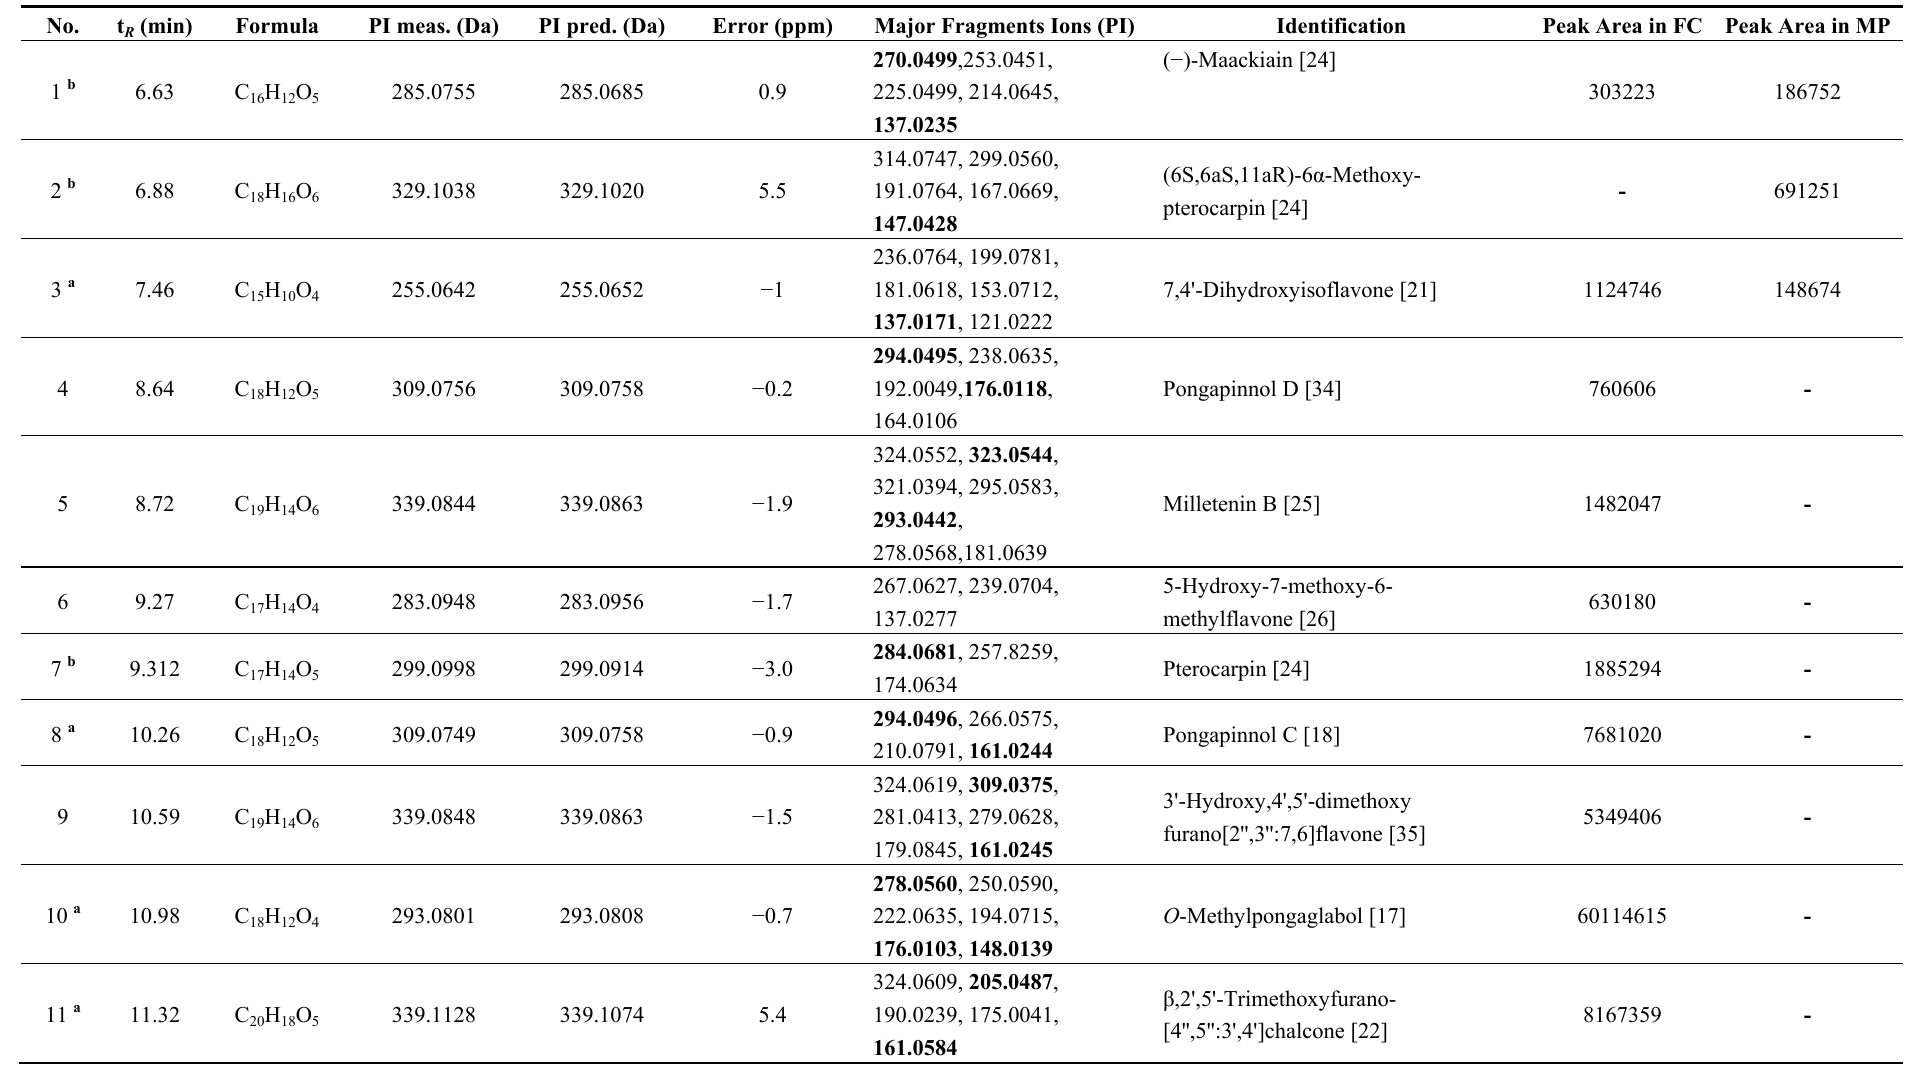
Table 1. Characterization of compounds detected in Fordiae Cauliflorae Radix (FC) and Millettiae Pulchrae Radix (MP) extract by HPLC-DAD-ESI-IT-TOF-MS n